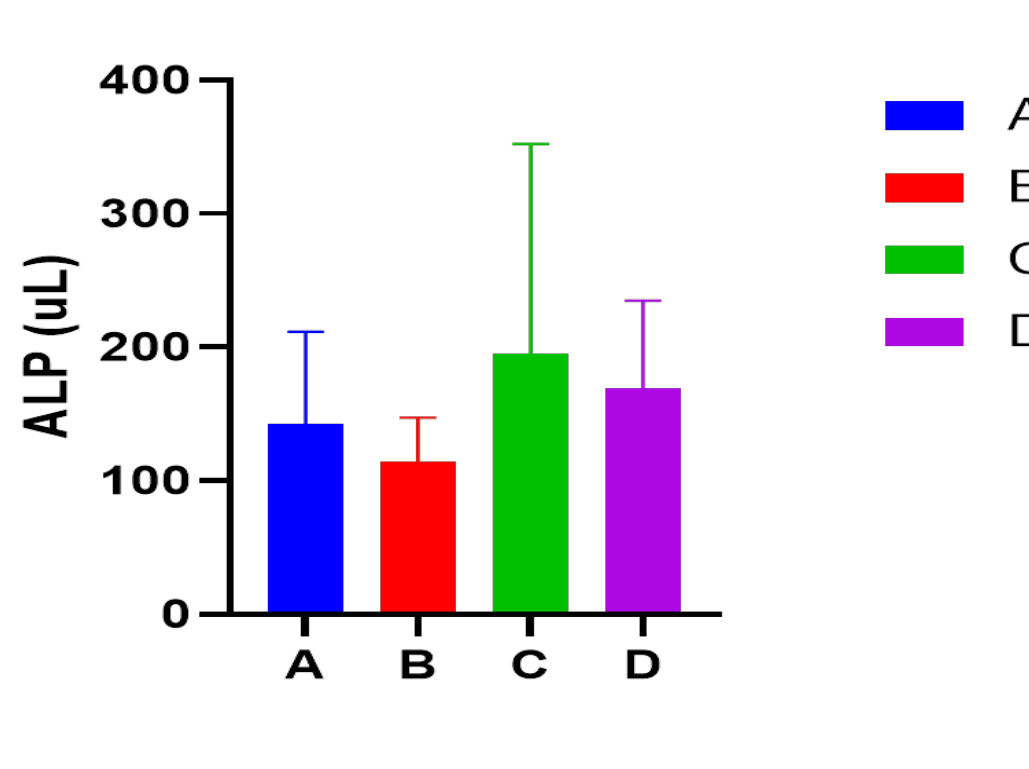
Fig.3: Graph showing the mean value of Alkaline Phosphatase (ALP) across the group